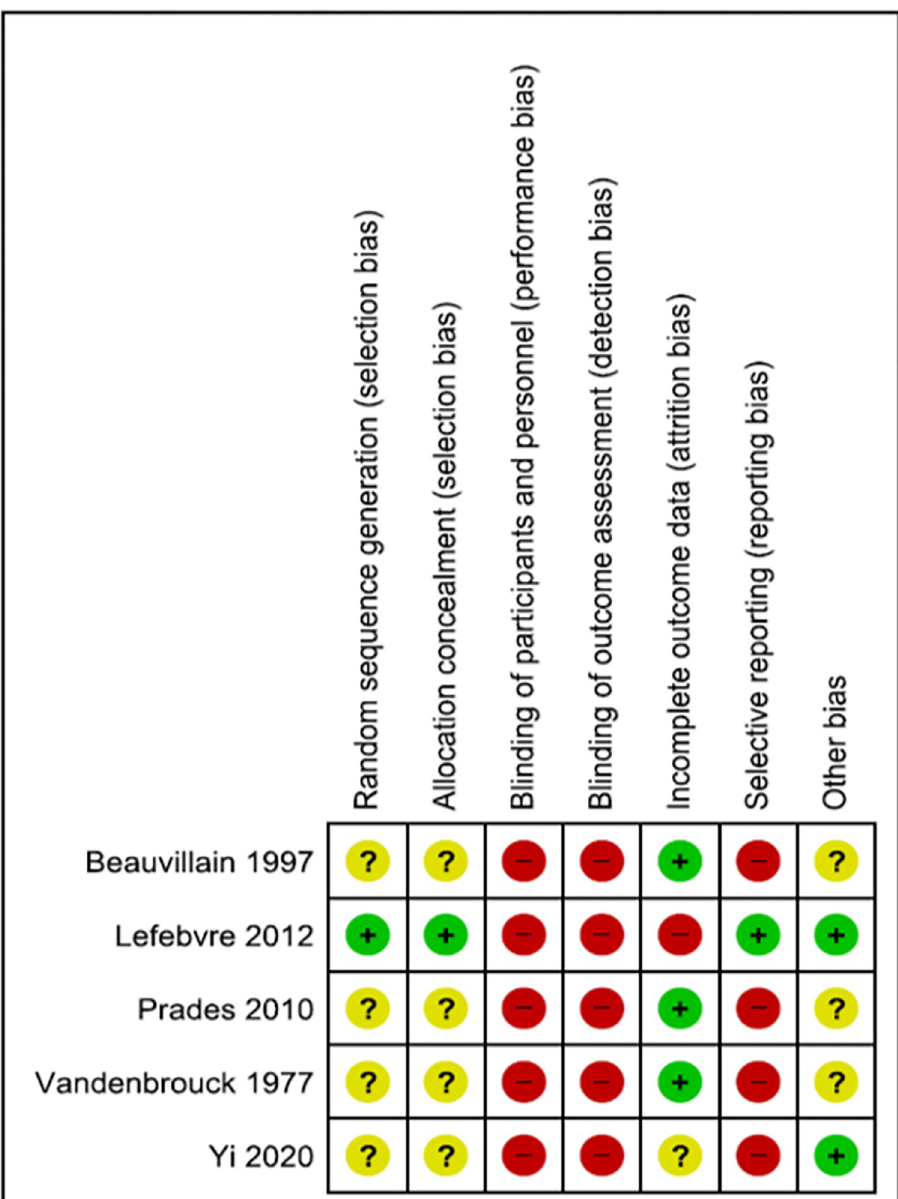
Fig 2. Figure demonstrating risk of bias